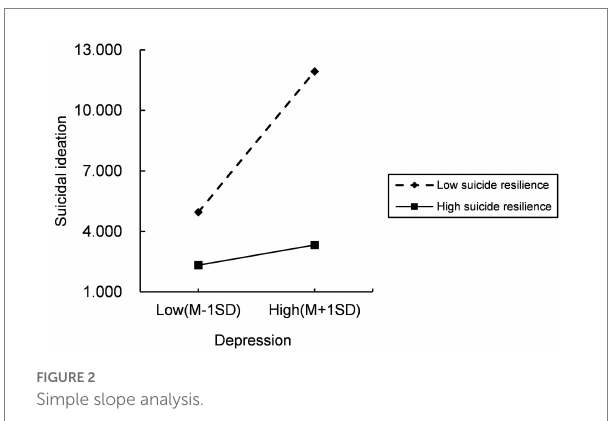
FIGURE 2 Simple slope analysis.